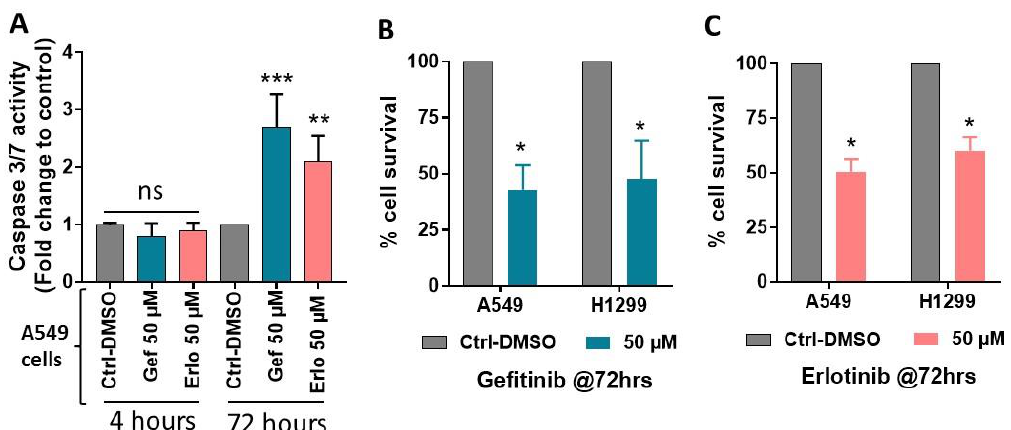
Figure 3. Effects of gefitinib and erlotinib on apoptosis induction and survival of NSCLC cell lines. ( A ) A549 cells were treated with 0.1% DMSO as vehicle control and Gef or Erlo at 50 µM dose. After 4 h and 72 h of incubation, apoptosis induction was assessed by quantitative caspase 3/7 activity assay. Similarly, ( B ) A549 and ( C ) H1299 cell lines were treated with vehicle control, and Gef or Erlo and after 72 h, cell survival was assessed by sulforhodamine B (SRB) assay. Data are expressed as mean ± SE of three independent experiments and represented as ( A ) Caspase 3/7 activity (Fold change to control) over treatment groups along with time points, and ( B , C ) % cell survival over treatment groups with their respective cell lines. Statistically significant differences were observed between Ctrl-DMSO and Gef or Erlo with their respective time points or cell lines used (* = p < 0.05, ** = p < 0.01, *** = p < 0.001); ns indicates non-significant changes between the analyzed groups.